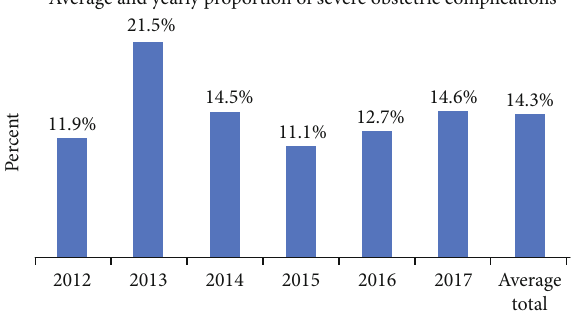
Figure 2: Yearly prevalence of near-miss cases among mothers admitted in selected hospitals of North Shewa Zone, Central Ethiopia, from 2012 to 2017 ( n = 129